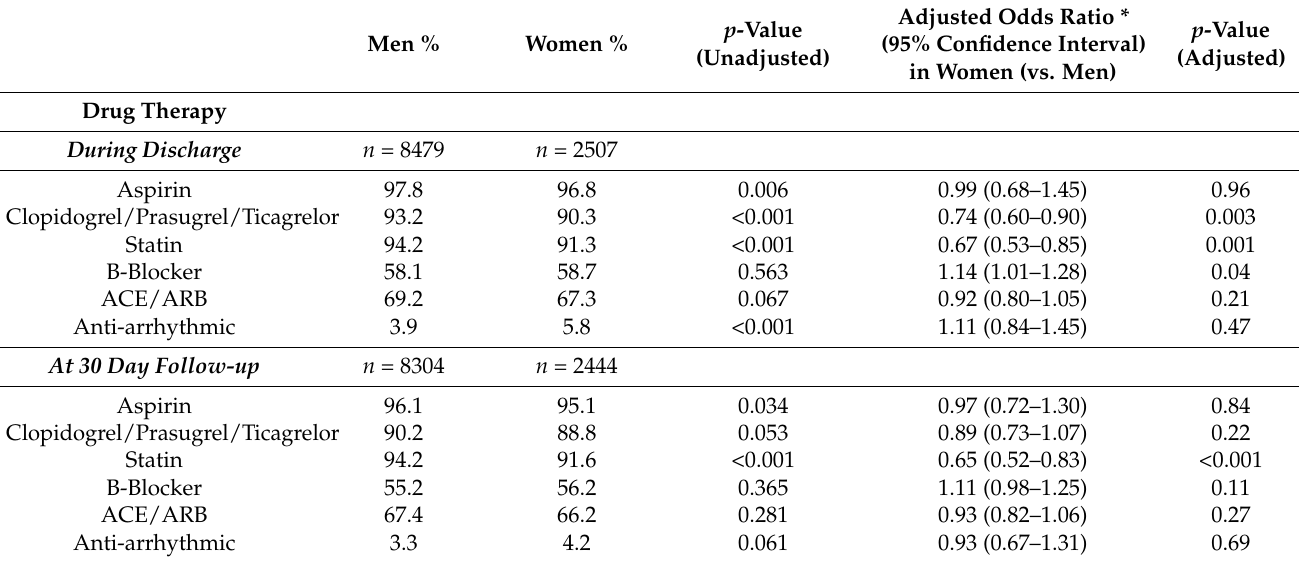
Table 4. Medication use at discharge and 30